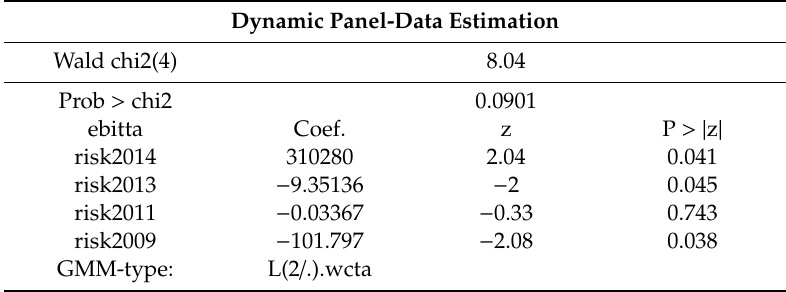
Table 7. Dynamic panel data